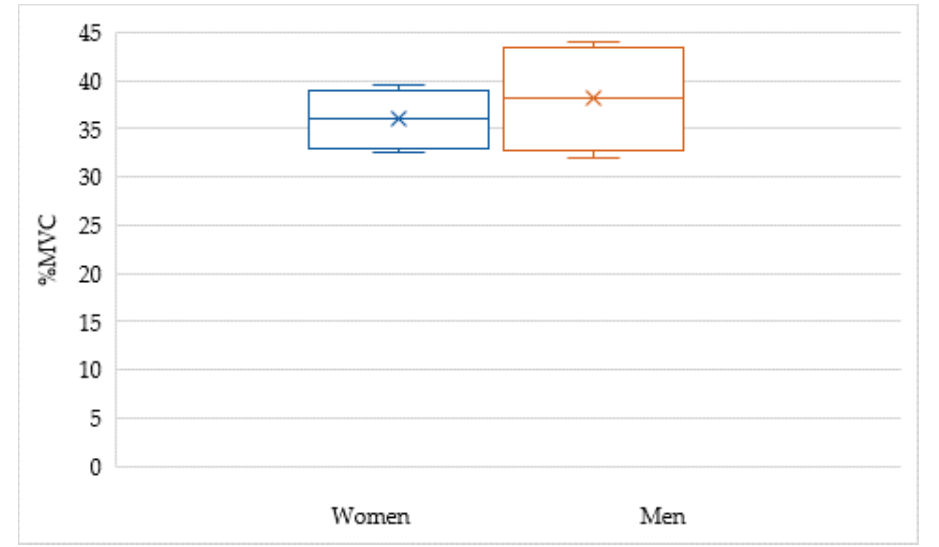
Figure 7. Load distribution of the examined farmers groups.